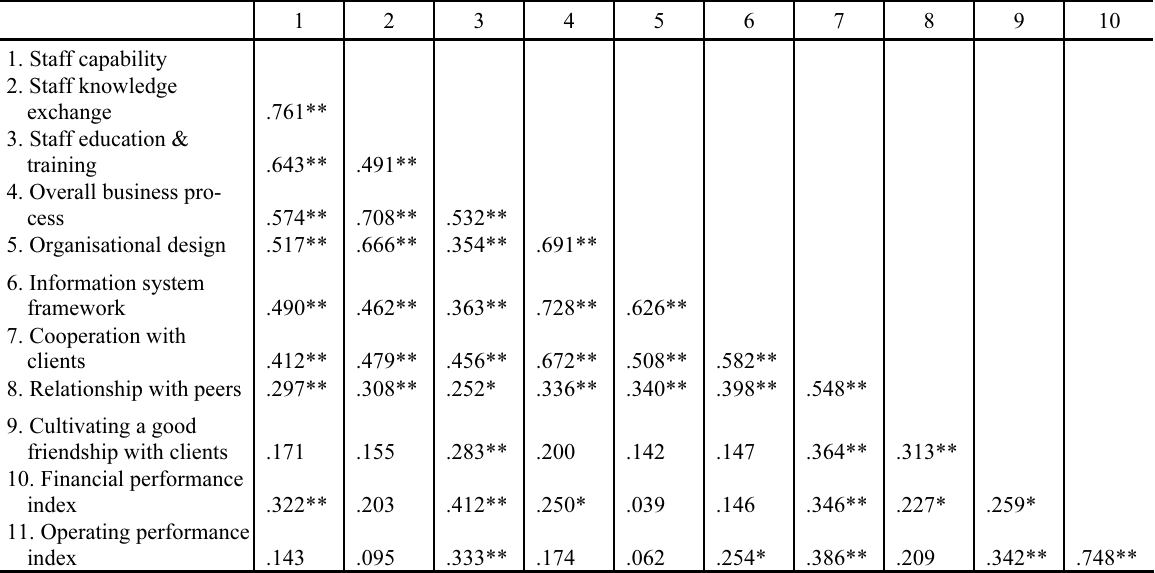
Table 4. Correlation matrix of measured